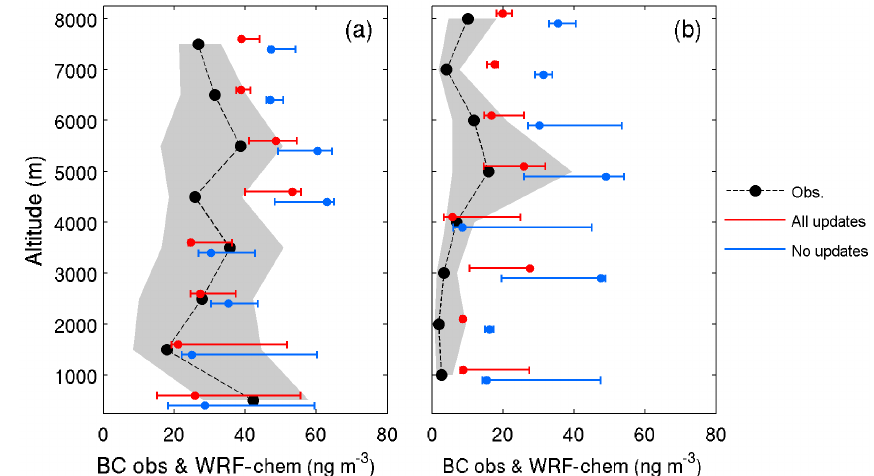
Figure 6. ARCTAS (a) spring and (b) summer median SP2 rBC (size range 90–1000nm) profiles north of latitude 70 ◦ N (gray shading indicates 25th and 75th percentiles) and WRF-Chem median BC (size range 80–1000nm) profiles interpolated along the same ARCTAS flights (red, ALL_UPDATES; blue, NO_UPDATES; error bars indicate 25th and 75th percentiles). Table 3. RMSE of individual WRF-Chem simulations relative to Arctic observations of aerosols and ozone. All sensitivity simulations are performed by deactivating updates from the ALL_UPDATES simulation; as a result, any increase in RMSE relative to ALL_UPDATES indicates that a given update improved RMSE. For surface measurements, RMSEs are calculated at each station and given as a network